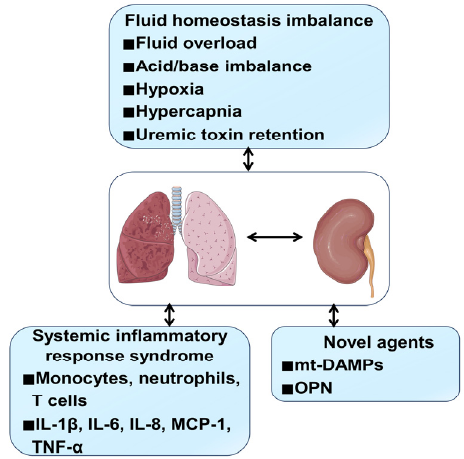
Figure 2. Mechanisms of kidney–lung interactions. Fluid homeostasis imbalance, systemic inflam- matory response syndrome, and some novel agents contribute to AKI-induced acute lung injury (ALI) or ARSD-induced kidney injury. The main fluid homeostasis imbalance mechanisms include fluid overload, acid/base imbalance, uremic toxin retention, hypoxia, and hypercapnia. Systemic inflammatory response syndrome mechanisms include pro-inflammatory factors release and immune cells response. Moreover, some novel mediators, such as mt-DAMPs and OPN, were identified as participating in kidney–lung interactions. Abbreviations: ARSD, acute respiratory distress syndrome; mt-DAMPs, mitochondrial damage associated molecular patterns; OPN,